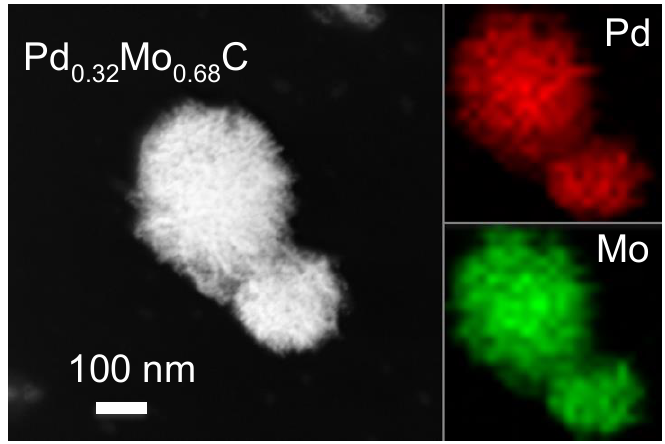
Figure 6. Dark-field TEM image of Pd-Mo cubic ternary carbide annealed to 1200 °C with 32% Pd. The elemental mapping of the particles shows uniform Pd (red) and Mo (green).